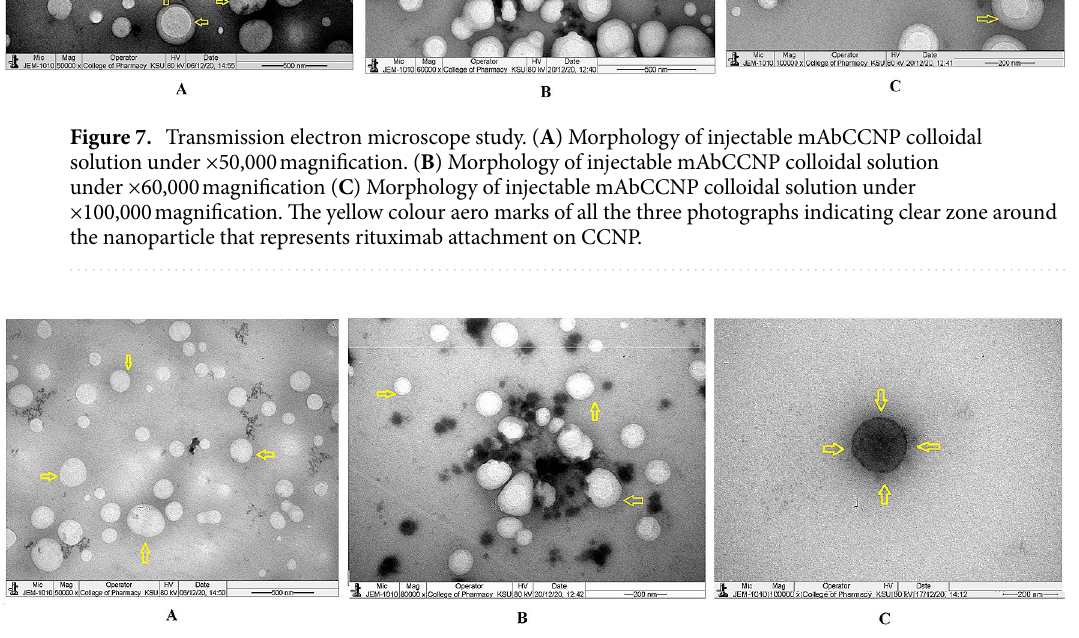
(Fig. 2C), which indicates low stability, and their physical properties are summarized in Table 1. The CCNP and mAbCCNP were successfully formulated and their physical characterization are represented in Table 2.